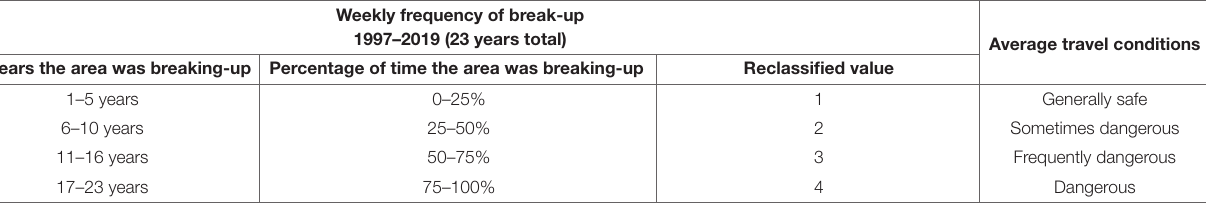
TABLE 4 | Classifications for the difference in the frequency of break-up maps for two time periods.